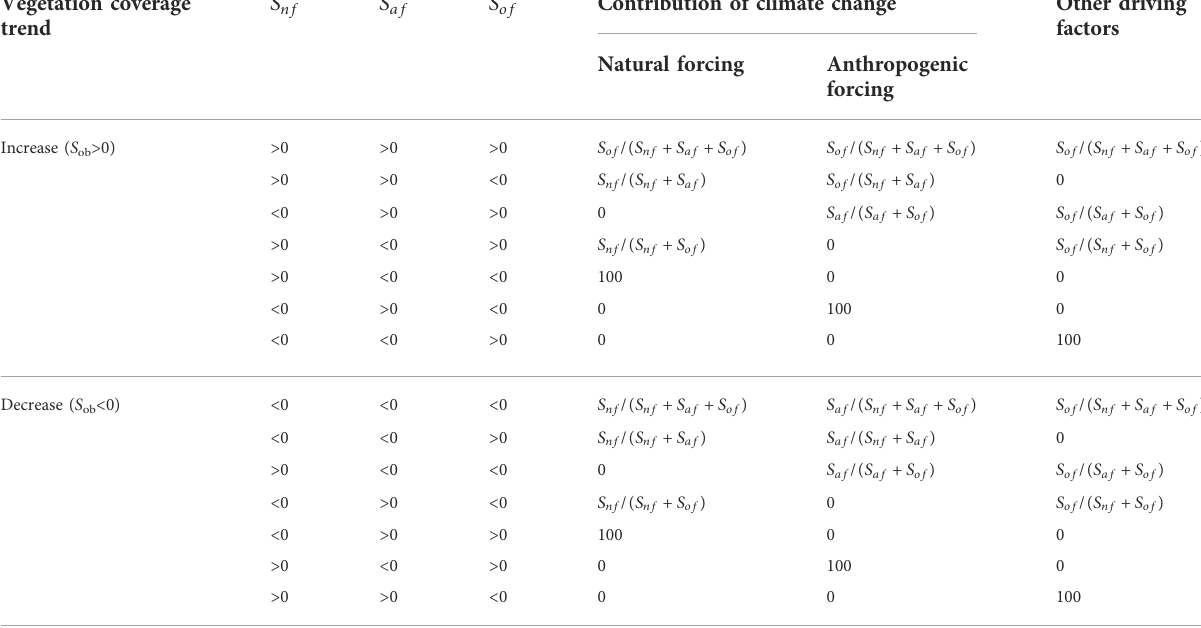
TABLE 1 Relative contributions of different factors to vegetation change. Vegetation coverage